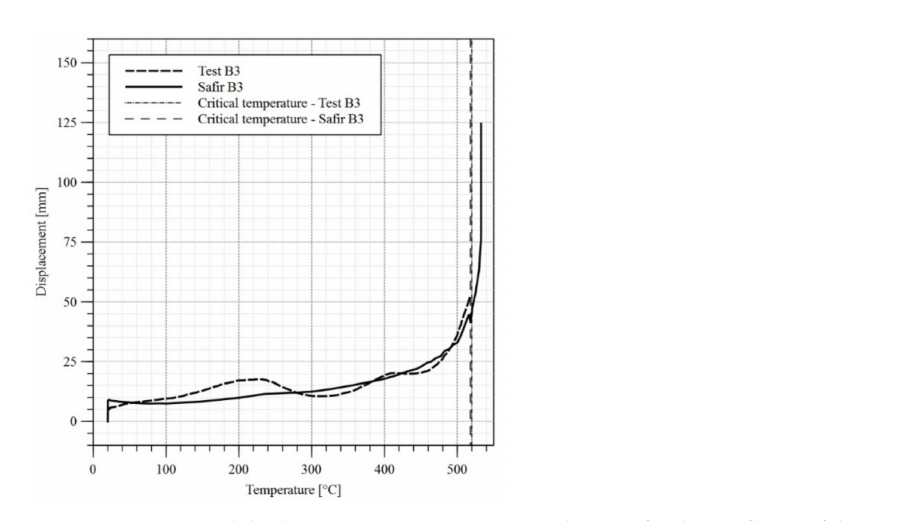
Figure 16. Horizontal displacement versus temperature diagram for the top flange of the girder—test